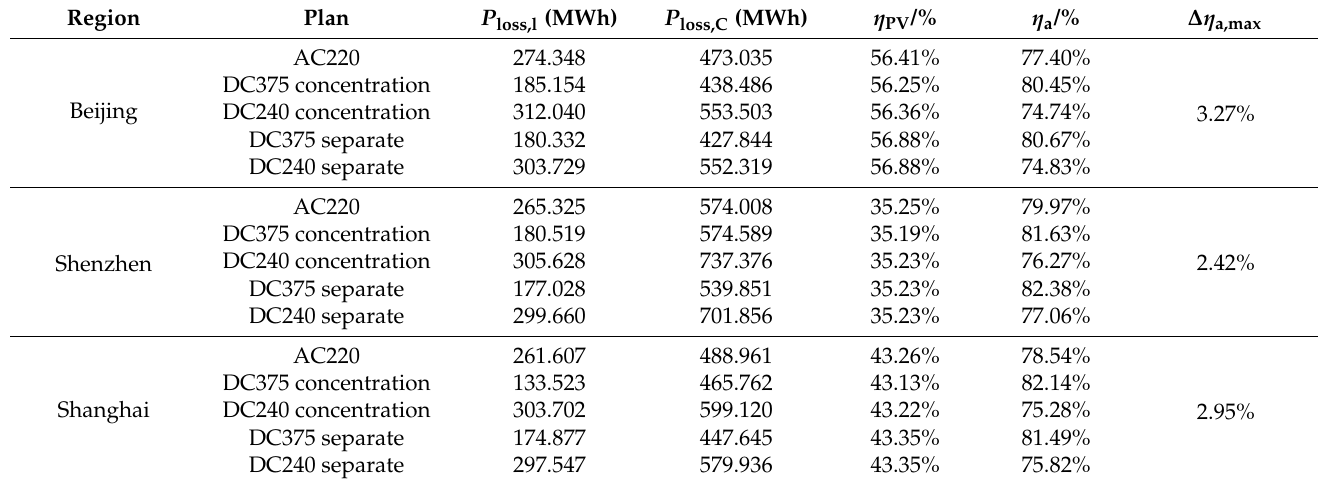
Table A3. Comparison of energy efficiency of business buildings with different topologies in three regions.